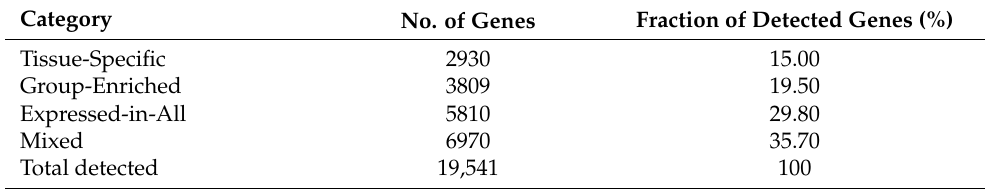
Table 3. Classification of protein-coding genes based on transcript expression levels and their index of tissue specificity ( τ ) across 10 pikeperch